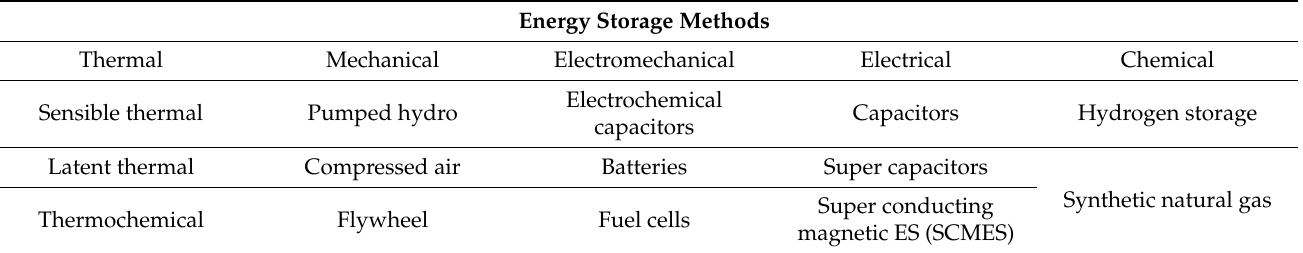
Table 1. Energy storage (ES) methods, reprinted/adapted with permissionfrom Ref. [3], 2022, Springer Nature [3].